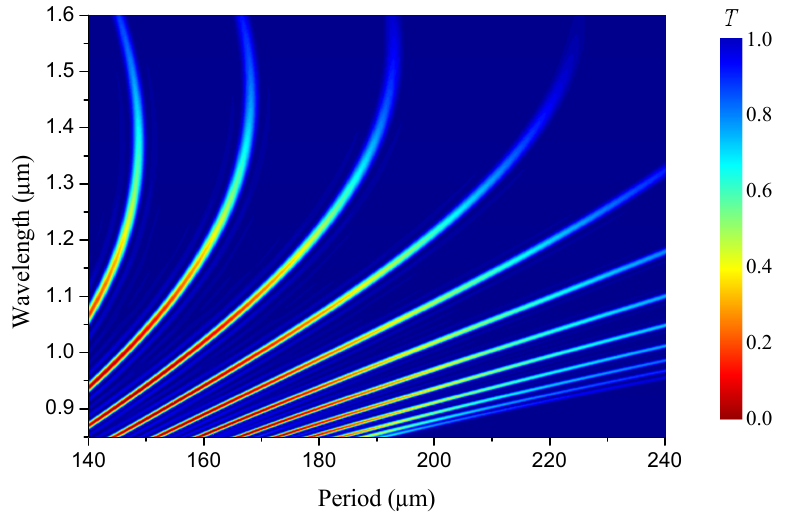
Figure 8. Spectra of LPFGs in B/Ge#1 fiber vs. grating period.